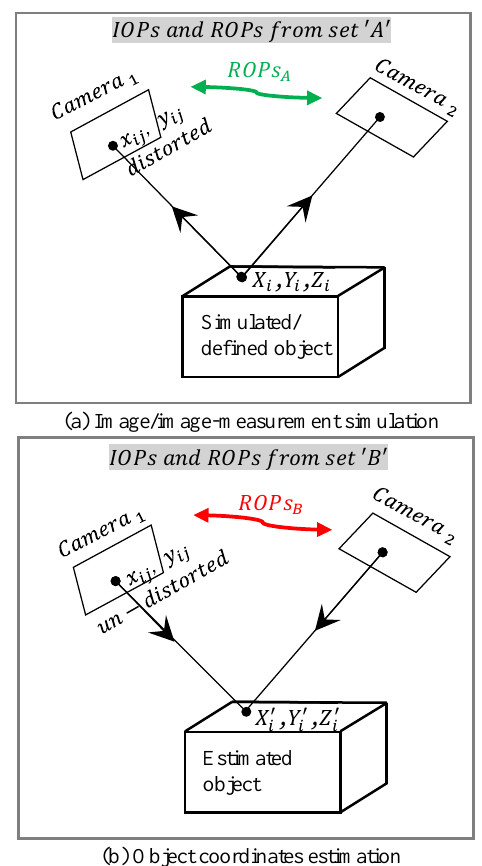
Figure 2.Stability analysis of a multi-camera